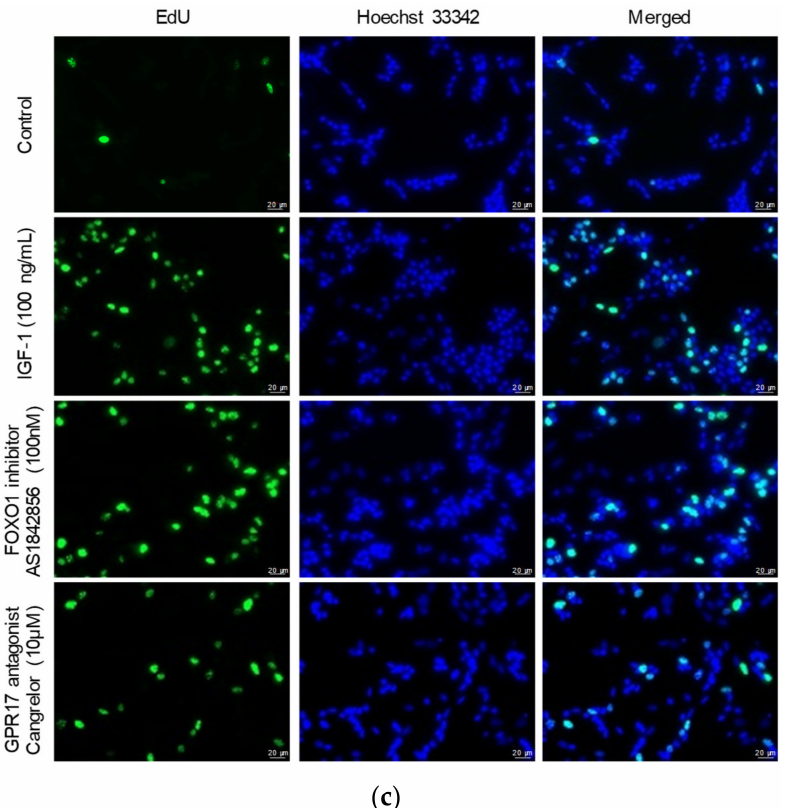
Figure 2. SK-N-SH cell viability and proliferation after treatment with IGF-1, a FoxO1 inhibitor and a GPR17 antagonist. ( a ) Viability of cells after treatment with IGF-1 (0, 25, 50, 100, and 200 ng/mL), a FoxO1 inhibitor (AS1842856; 0, 50, and 100 nM), and a GPR17 antagonist (cangrelor; 0, 5, and 10 µ M); ( b ) cellular proliferation induced by 100 ng/mL of IGF-1, 100 nM of AS1842856, and 10 µ M of cangrelor; ( c ) representative images of 5-ethynyl-2-deoxyuridine (EdU) staining in cells with or without treatment with 100 ng/mL of IGF-1, 100 nM of AS1842856, and 10 µ M of cangrelor. (Scale bar: 20 µ m) ** p < 0.01 vs.